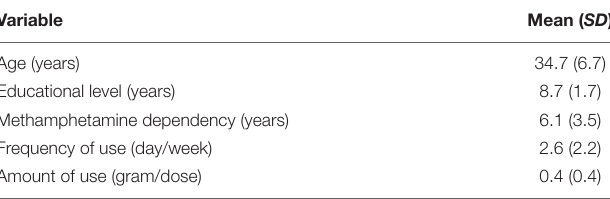
TABLE 1 | Demographic and drug-taking characteristics of the study sample.